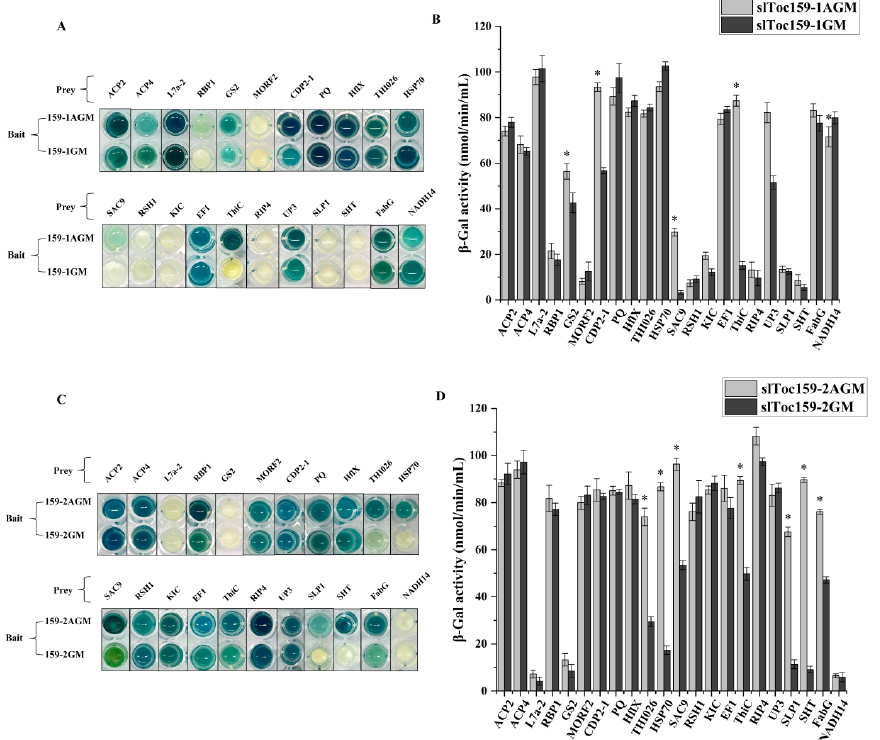
Figure 6 . Interactions of non-photosynthesis-related prey proteins with four bait proteins (slToc159- 1AGM, slToc159-1GM, slToc159-2AGM, slToc159-2GM). ( A , C ) Independent transformants were assayed per protein interaction, scanned image of a PXG assay in a 96-well microtiter plate after 60 min of incubation. ( B , D ) Quantitative b-galactosidase activity assay. Strains co-expressing respective bait and prey constructs were used in a 96-well microtiter plate-based β -galactosidase assay using (X-Gal) as a substrate. The graph shows β -galactosidase activity/mL per min measured after 60 min. The values represent the mean of three independent experiments. Values marked with asterisks are significantly different (Student’s t -test; p ≤ 0.05).